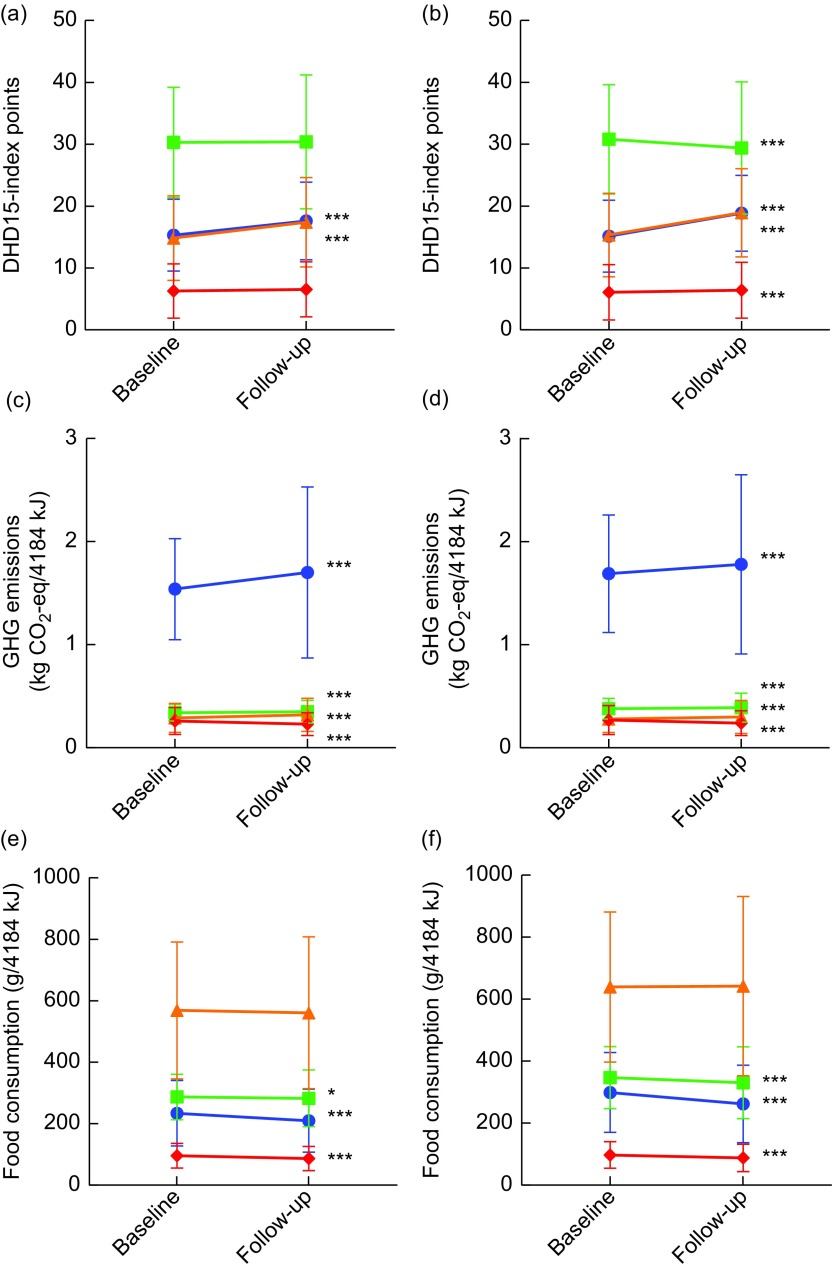
(a, b) Points on the Dutch Healthy Diet 2015 index (DHD-15 index), (c, d) greenhouse gas (GHG) emissions per 4184 kJ (1000 kcal) and (e, f) food consumption per 4184 kJ, at baseline and follow-up, by sex (a, c, e, men; b, d, f, women) and per food type† (, animal-based foods; , plant-based foods; , beverages; , miscellaneous), in the European Prospective Investigation into Cancer and Nutrition – Netherlands (EPIC-NL) cohort. Values are means with their sd represented by vertical bars. Significance level of paired t test: *P < 0·05, ***P < 0·0001. †Animal-based foods include red and processed meat, poultry (shell)fish, eggs and dairy. Plant-based foods contain potatoes, fries, bread and cereals, fruit, vegetables, vegetarian meat replacers, nuts, seeds and nut paste. Beverages include coffee, tea (light) soft drinks, fruit and vegetable drinks, and alcoholic beverages. Miscellaneous contains savoury snacks, cakes/cookies, soups, sauces, oils and fats, and sweets. Animal-based foods could score a potential 30 points on the DHD15-index, plant-based foods 50 points, beverages 30 points and miscellaneous 10 points